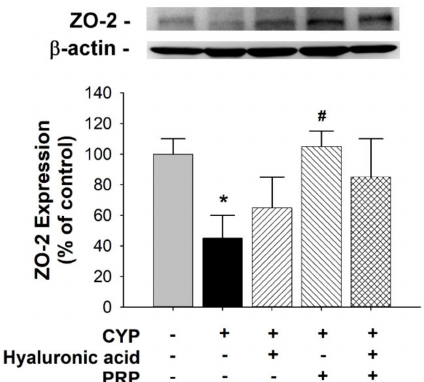
Figure 6. Alteration of ZO-2 expression in the bladder as indicated by Western blot analyses between saline-injected control, CYP plus intravesical instillation with normal saline, CYP plus intravesical instillation with hyaluronic acid (1 mg / mL), CYP plus intravesical instillation with PRP, and CYP plus intravesical instillation with hyaluronic acid (1 mg / mL) plus PRP groups. Each bar denotes the mean ± SD of six individual rats. * p < 0.05 compared to the control group. # p < 0.05 contrasted to the CYP